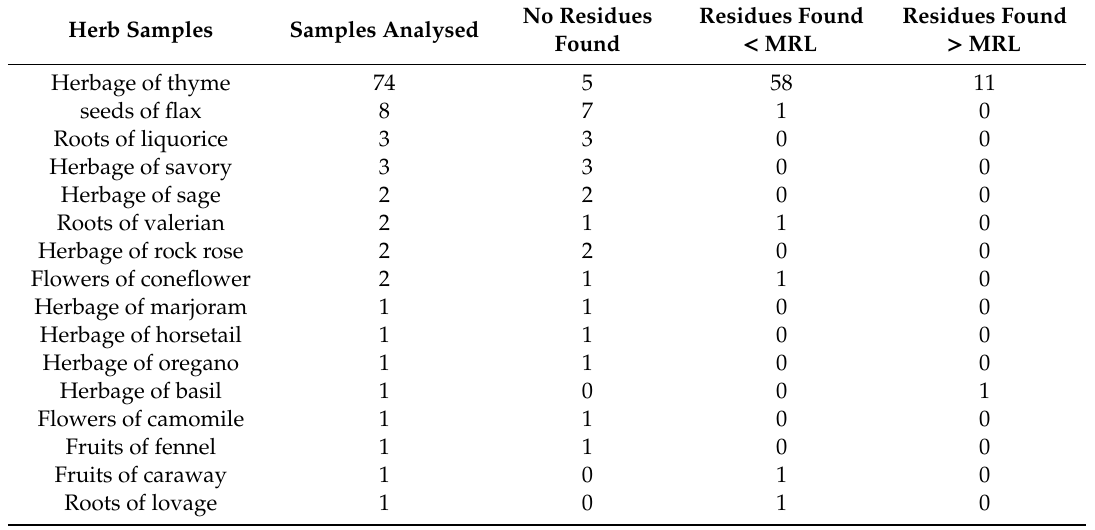
Table 1. Number of samples with and without detected pesticides residues for each analysed herb sample.